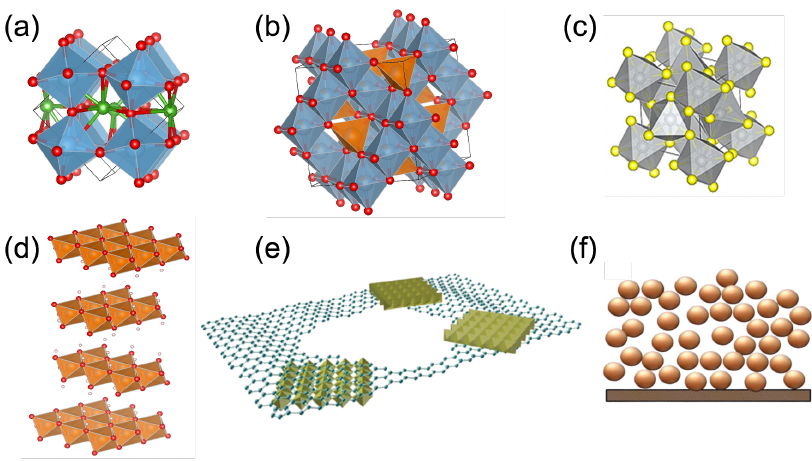
Figure 4. General structure of ( a ) perovskite, ( b ) spinel, ( c ) pyrite [91], ( d ) layered structure, ( e ) exam- ple of a heterostructure [77], and ( f ) scheme of an amorphous structure